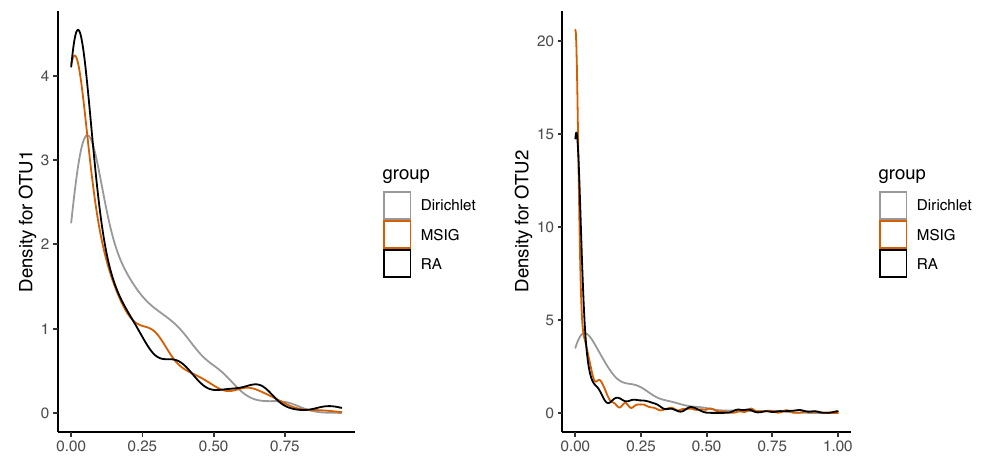
Figure 2. The estimated marginal density functions: the black line is estimated by the samples, the gray line by Dirichlet distributions, and the red line is by MSIG